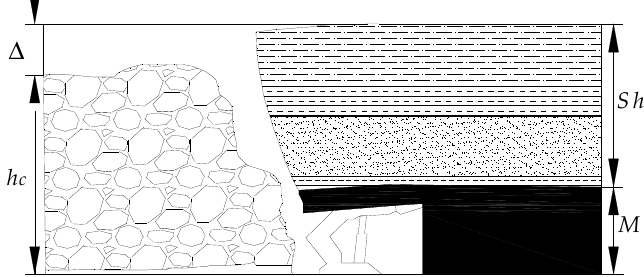
Figure 11. Sketch-profile evidencing variations in the relationship between k p , k i and filling rate.